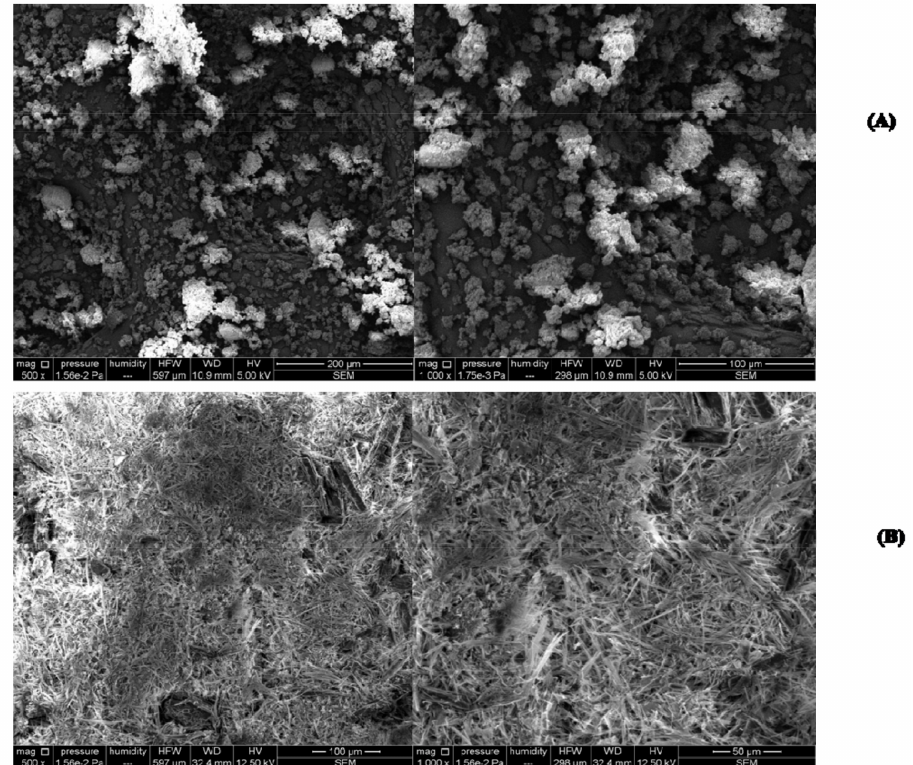
Figure 2. SEM images of ( A ) RUT- β -CD inclusion complex, ( B ) RUT-HT- β -CD inclusion complex, at different